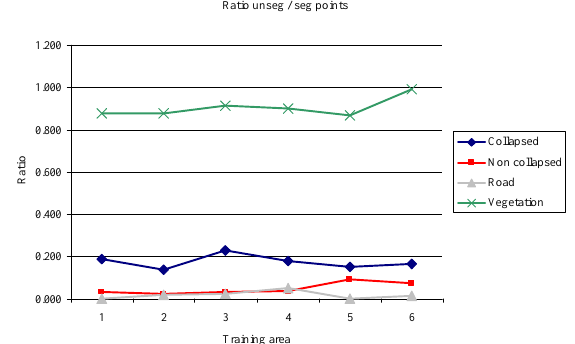
Figure 2 Values for the ratio between number of unsegmented points and segmented points (NUSPR), for 4 classes in 6 training areas.